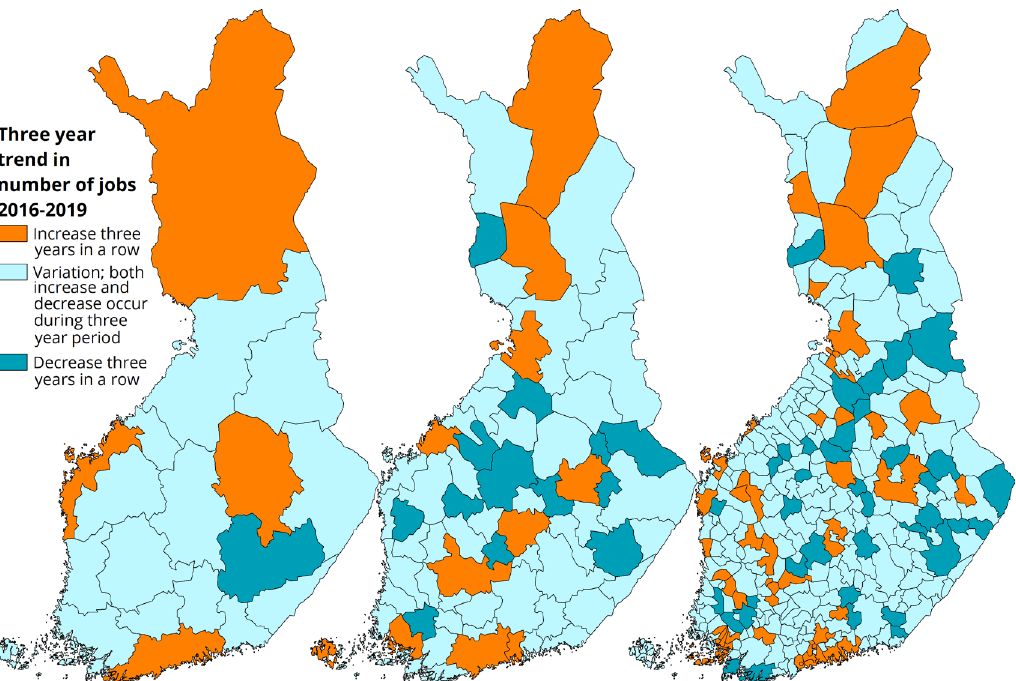
Fig. 10. Changes in regional employment (jobs) in Finland,